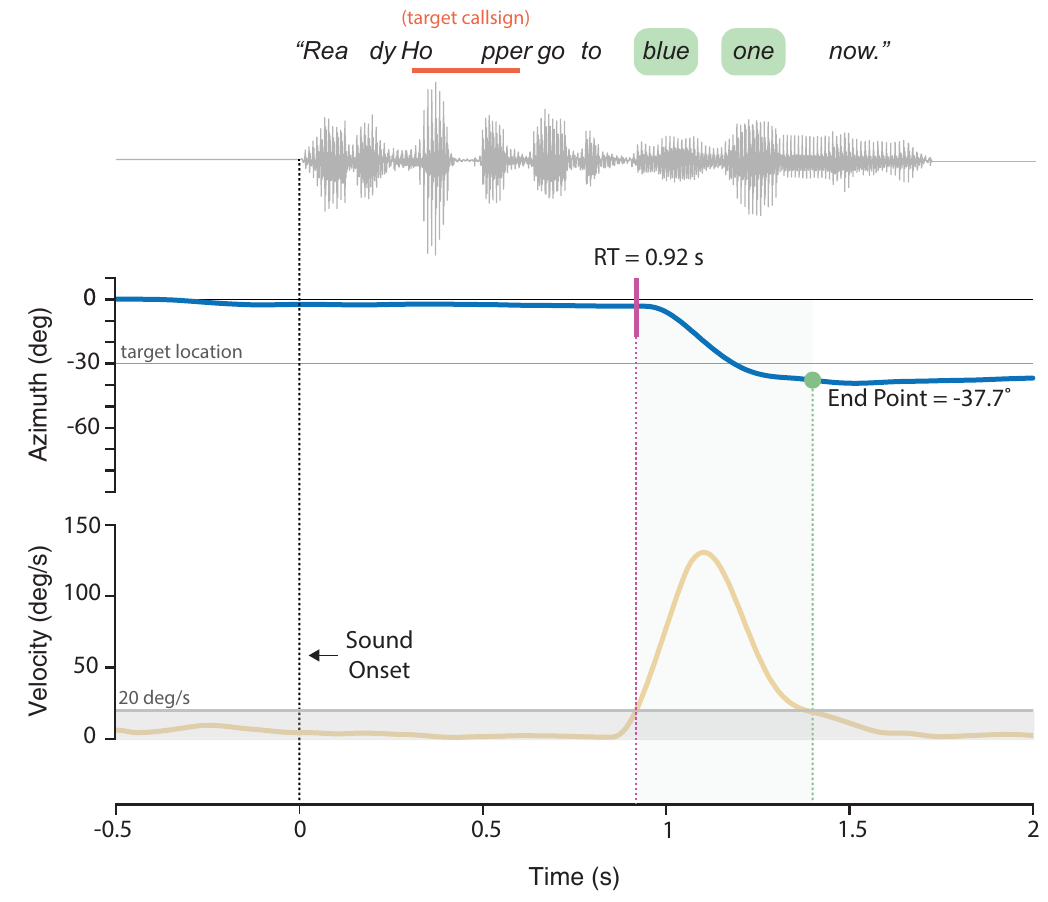
Fig 2. Analysis of localization response using head tracking. A sample target stimulus from the CRM corpus is presented with its associated waveform. The target call sign used was “hopper” and the associated color/number to be repeated are indicated in green. The upper panel shows the head position in azimuth (degrees) and lower panel shows the velocity of the head movement (degrees/second). RT is calculated as the time between the onset of the stimulus and initiation of the head movement. The endpoint of the head movement is set once its velocity profile falls below 20˚/s (grey shaded